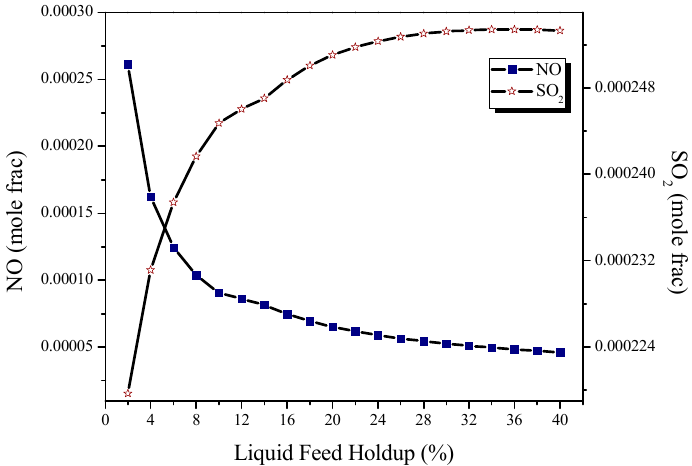
ff ect of liquid holdup on vapor product Figure 10. Effect of liquid holdup on vapor product composition. Figure 10. E